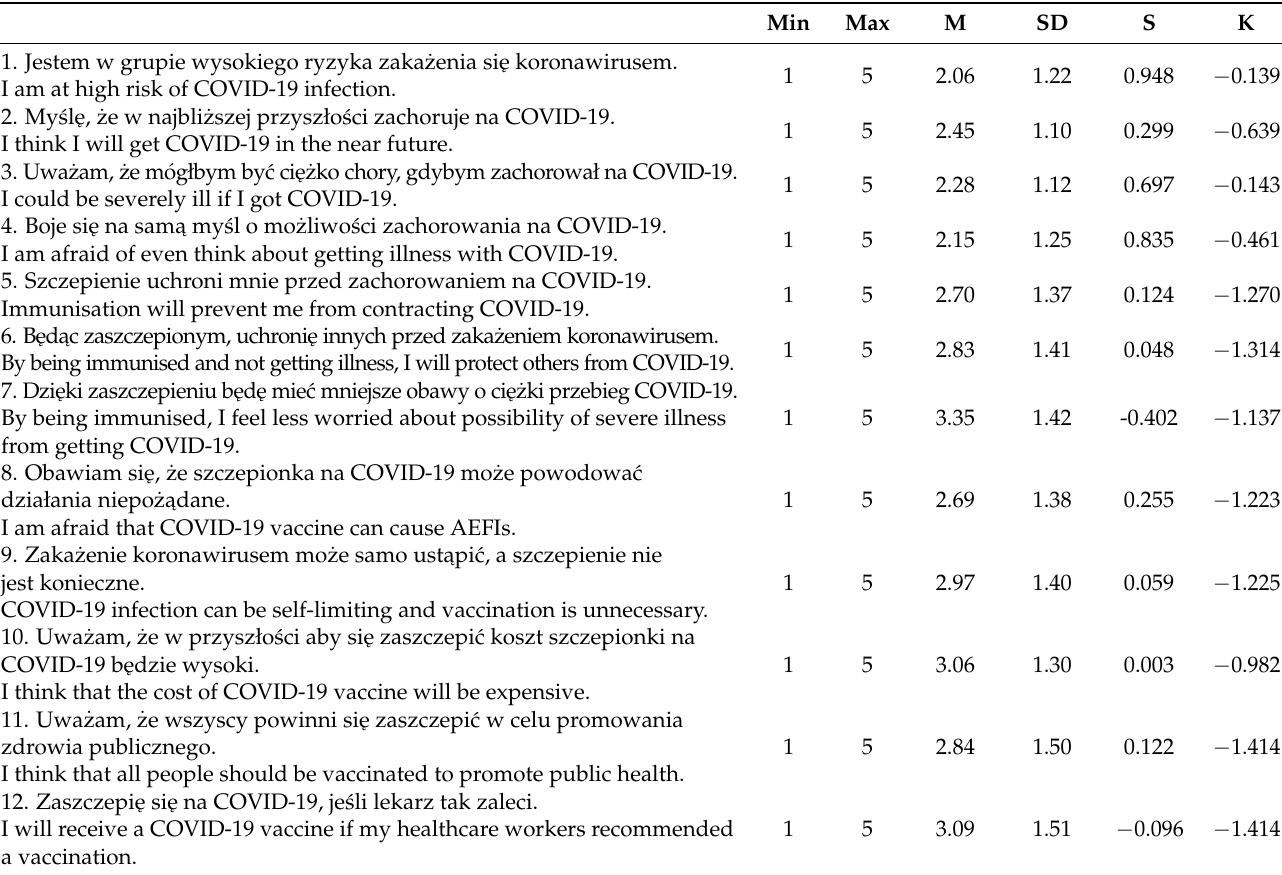
Table 2. Descriptive statistics of the items in Polish and English